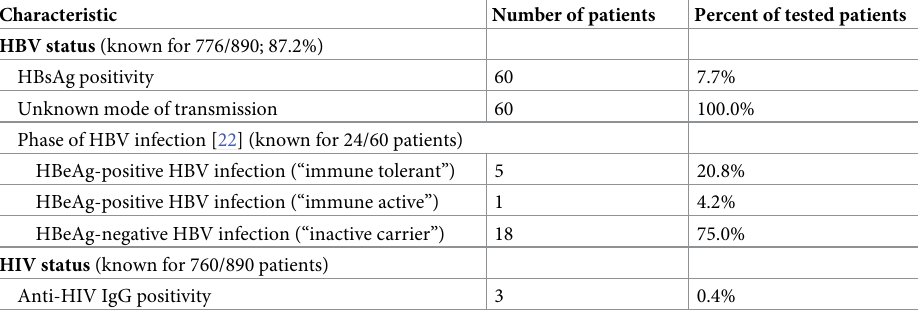
Table 1. Screening for hepatitis B ( n = 776), and HIV ( n = 760). Characteristic Number of patients Percent of tested patients HBV status (known for 776/890;